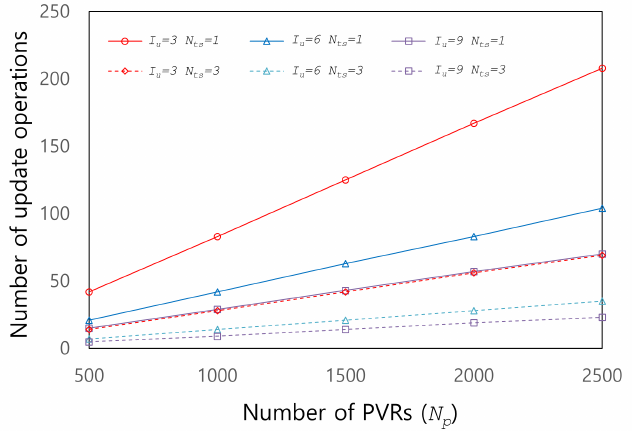
Figure 16. The number of the aggregate buffermap update operations according to N p with a 300 s